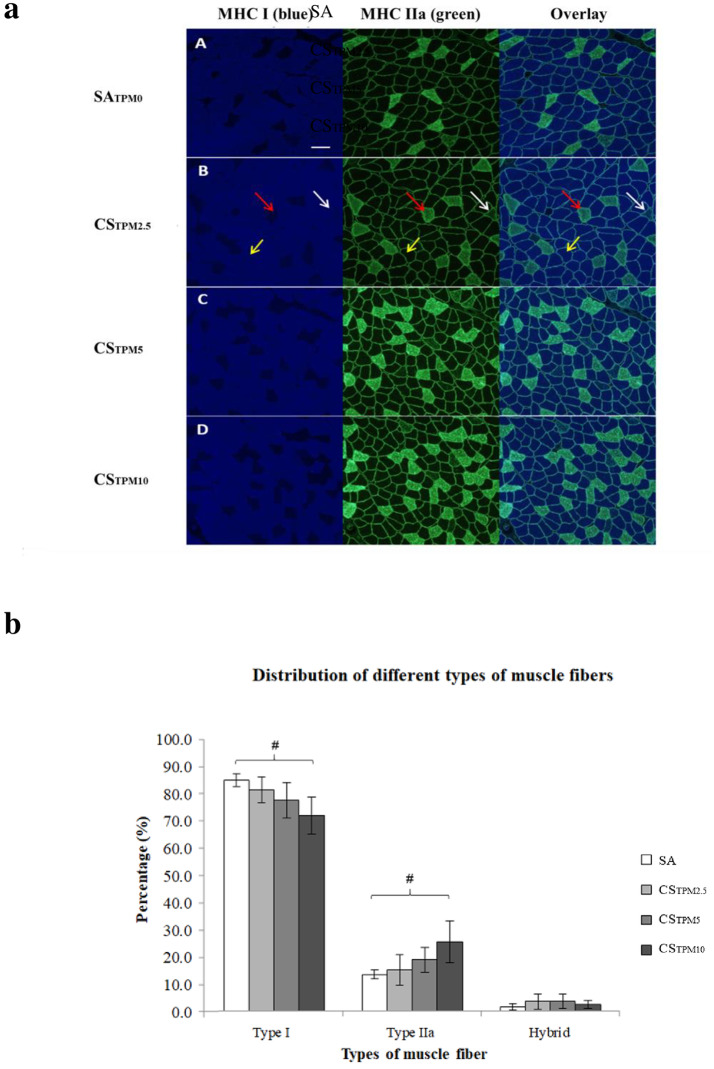
Muscle fiber types changes in soleus muscles upon acute cigarette smoke exposure.(a) Cross-sections of soleus muscles from SA (A), CSTPM2.5 (B), CSTPM5 (C) and CSTPM10 (D) groups showing immunoreactivity against MHC I (blue, left panel), MHCIIa (green, middle panel) and the overlaid images (right panel). Examples of type I fibers (yellow arrows), type IIa fibers (red arrows) and type I/IIa hybrid fibers (white arrows) were indicated. Scale bar = 100μm. (b) Histogram summarizing the percentage distribution of type I, type IIa and type I/IIa hybrid fibers in soleus from SA group and CS groups. All data are presented as mean ± SEM. * indicates p<0.05 for overall ANOVA comparison; # indicates p<0.05 in post-hoc analysis.